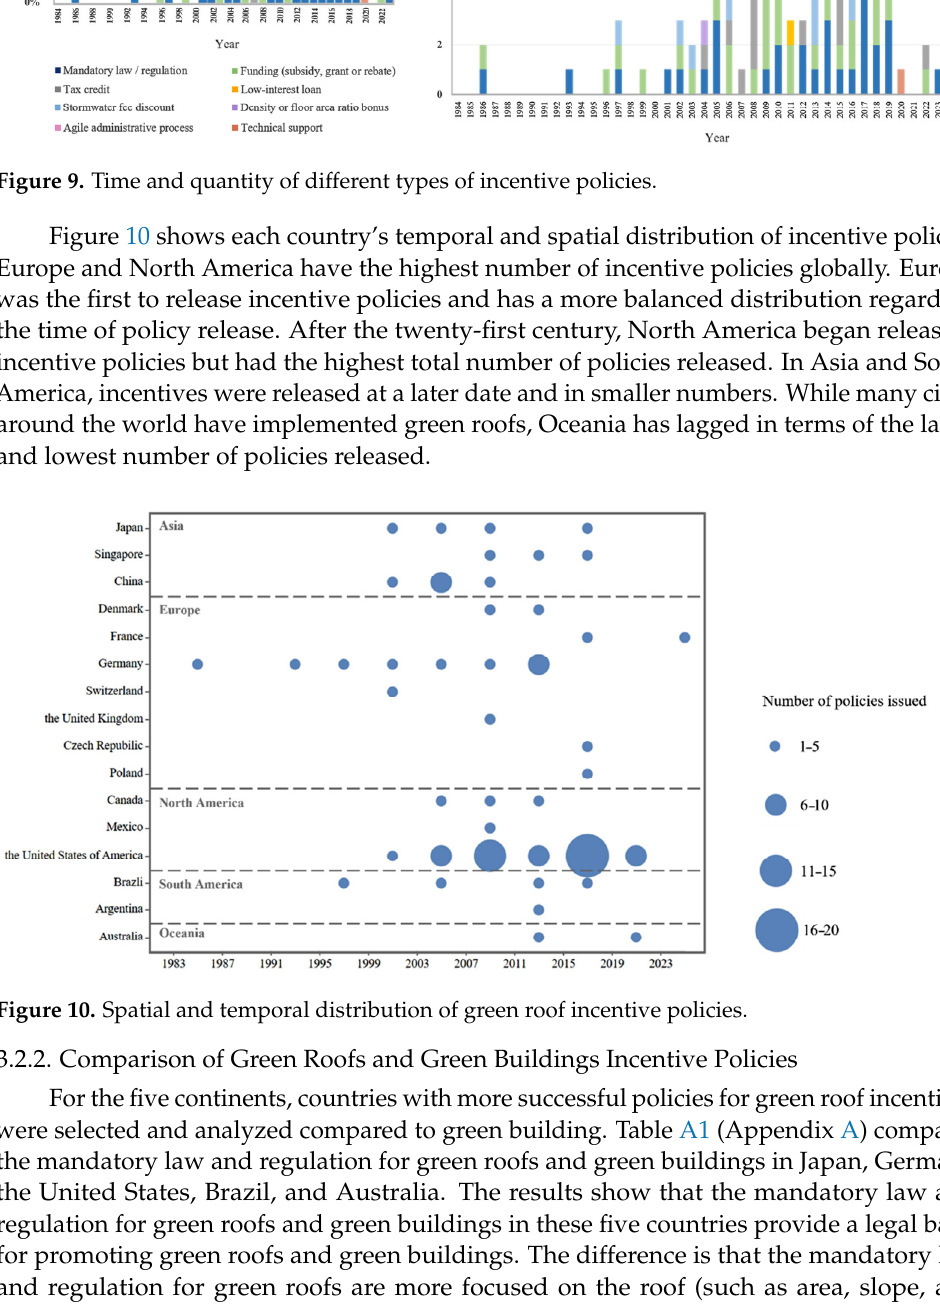
Figure 9. Time and quantity of different types of incentive policies.